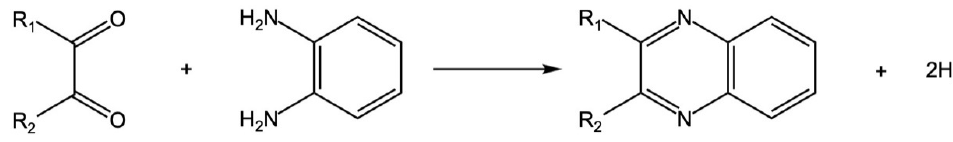
Figure 1. The reaction equation of OPD and α -DCs. Figure 6. Reverse aldol condensation of G to produce GO.